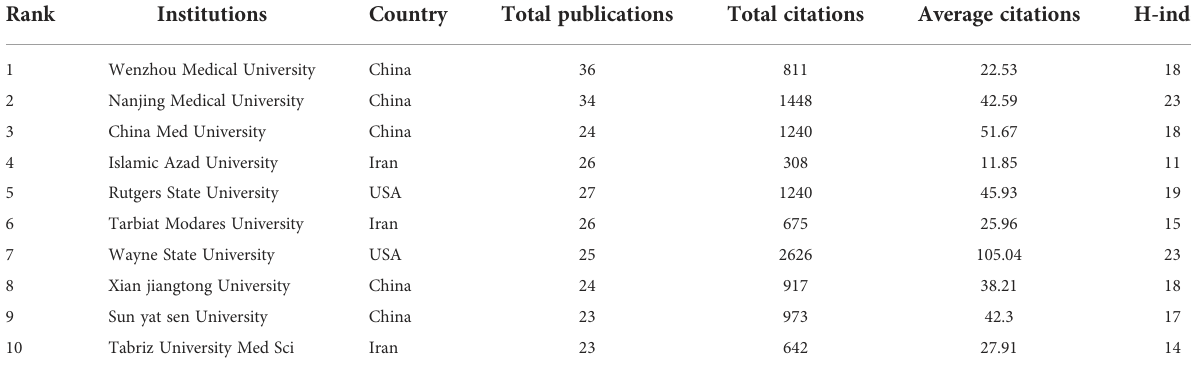
TABLE 2 The top 10 institutions that contributed publications on curcumin.